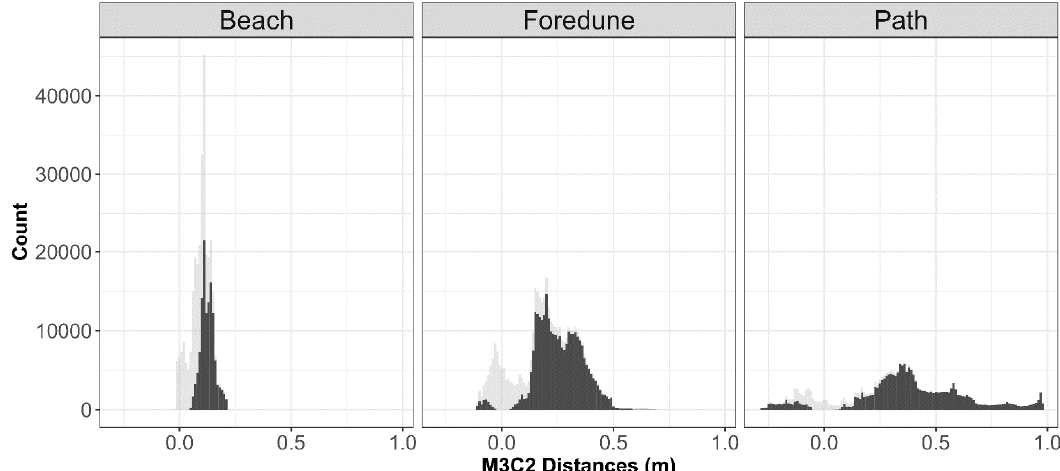
Figure 9. Analysis of M3C2 change clouds for specific features within the study system. Change was calculated between surveys 4 and 6 (12 month timespan). Histograms show the distribution of all points (light grey) overlaid with the distribution of significant change points (dark grey) for each of the three features (beach, foredune, path)